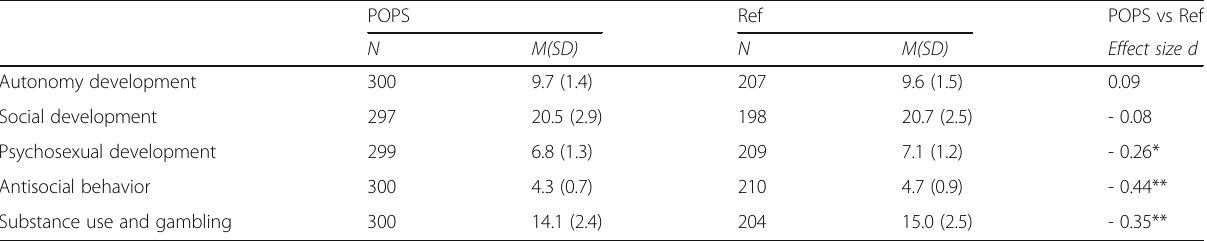
Table 3 Psychosocial development trajectory of POPS-group vs Ref-group: scale scores Course of life questionnaire